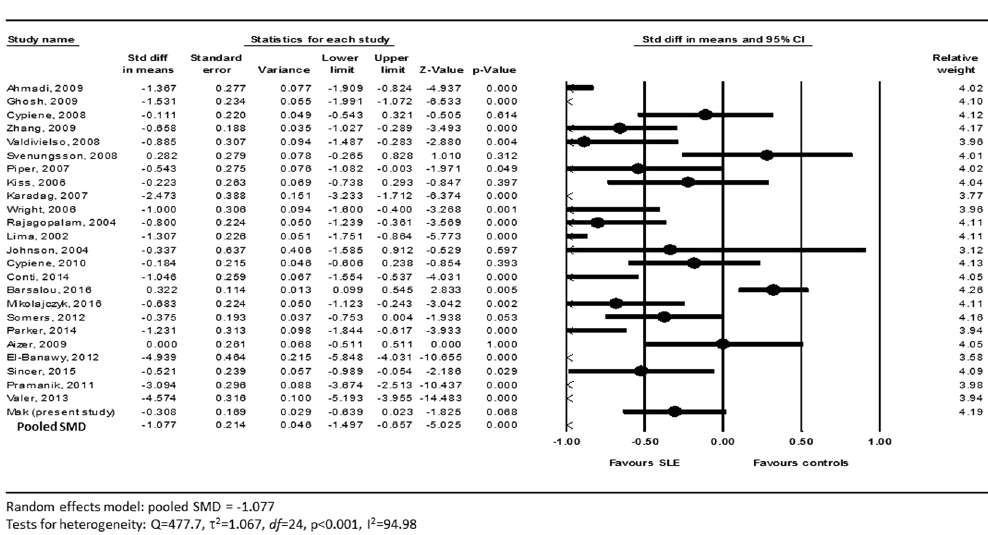
Table 2. Characteristics of studies comparing brachial artery endothelium-dependent flow-mediated dilation in patients with systemic lupus erythematosus and matched healthy controls. Abbreviations: N, number; EDD, endothelium-dependent dilation at brachial artery; SD, standard deviation; EID, endothelium-independent dilation at brachial artery; NR, not reported. * Estimated by multiple imputation with 1,000 imputations; ** median.